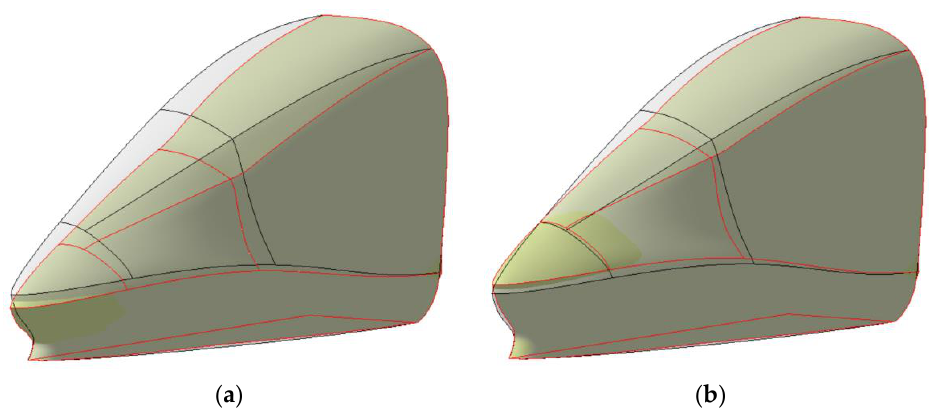
Figure 9. Pareto front.